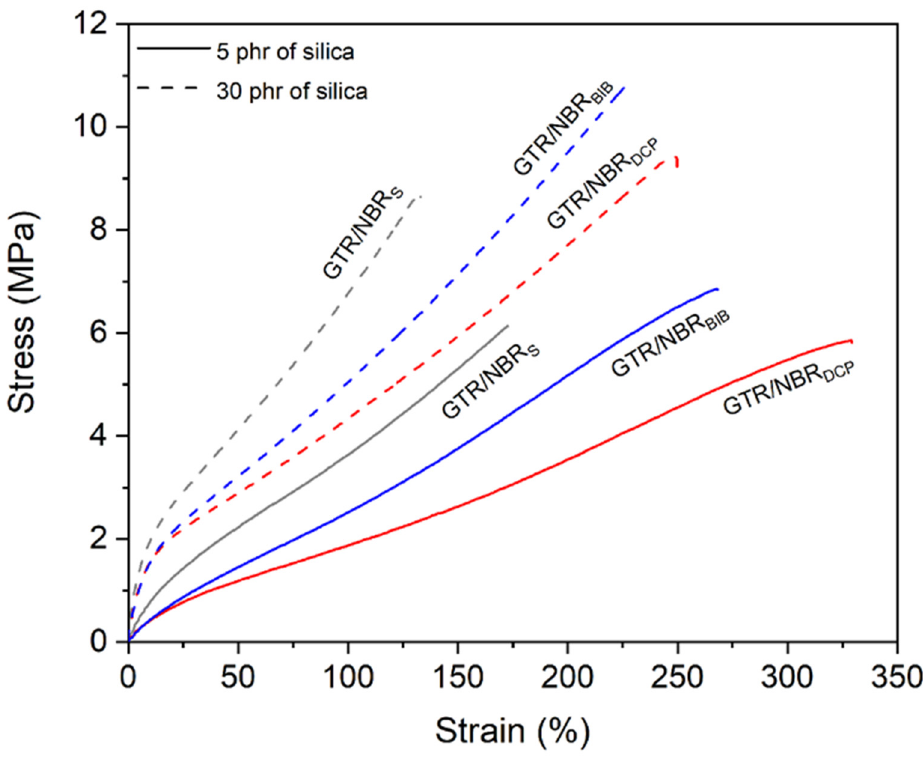
Figure 3. Stress–strain curves of modified GTR/NBR sintered at 160 °C (sulfur curing system) and at 180 °C (peroxides).